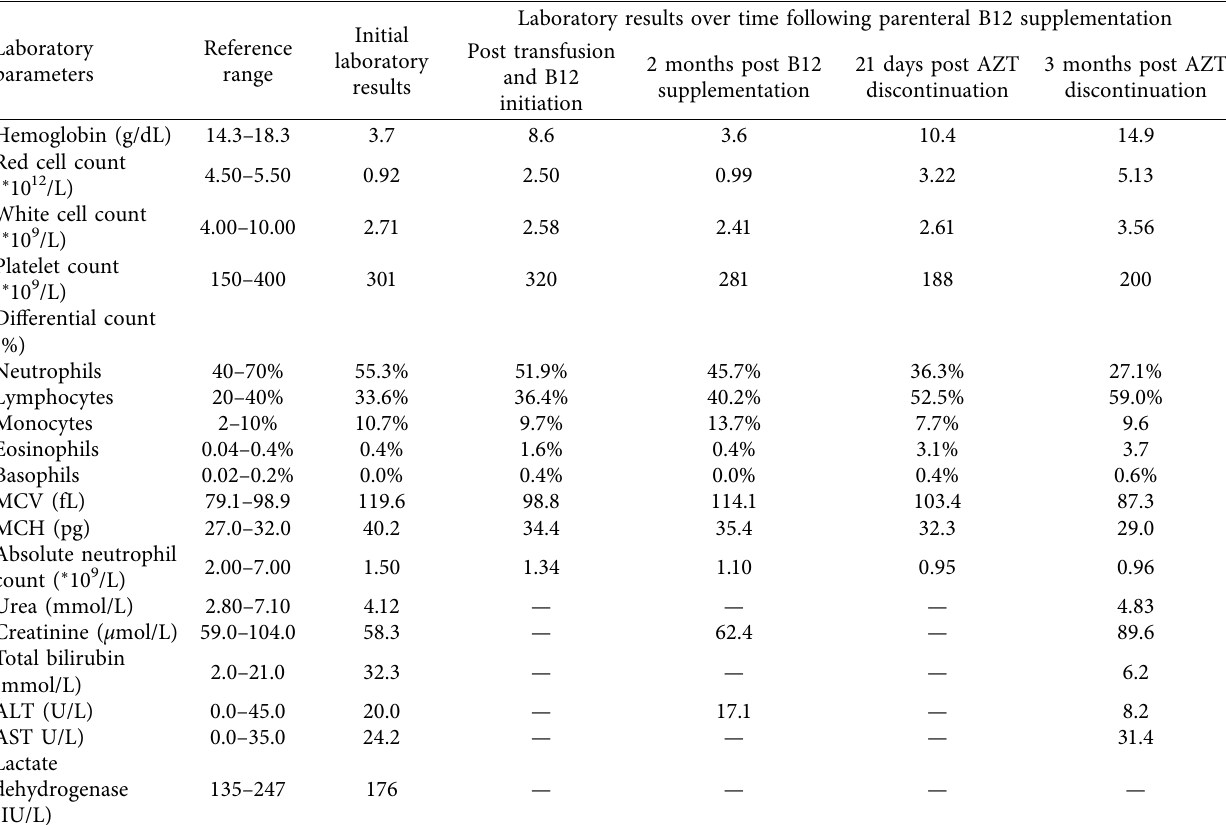
Table 1: Laboratory results at initial diagnosis and at follow-up